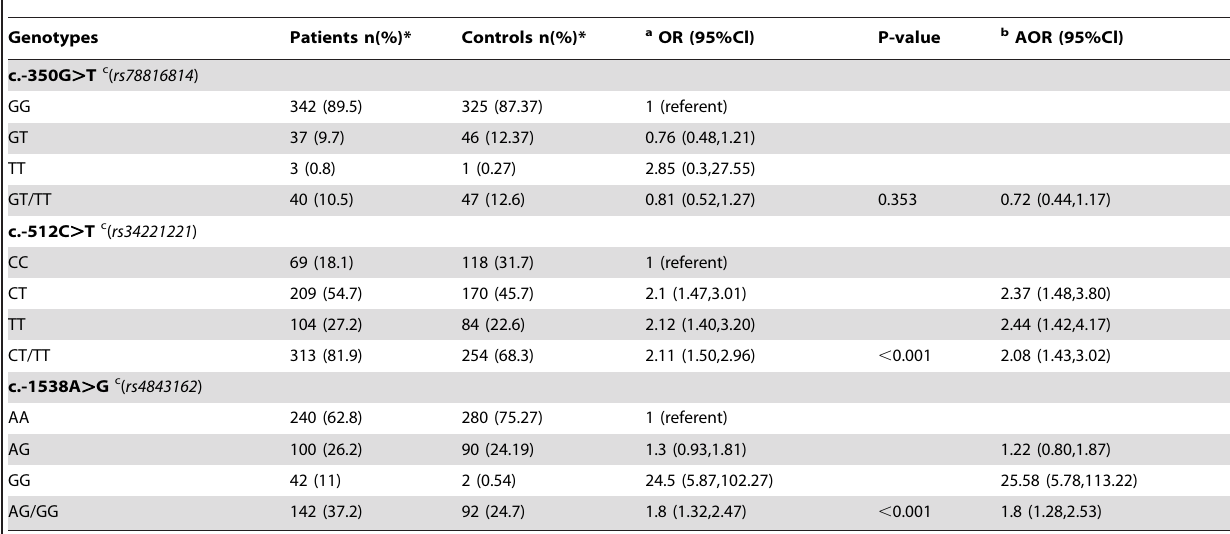
Table 3. Association between FoxC2 genotypes (reported) and CVD risk.